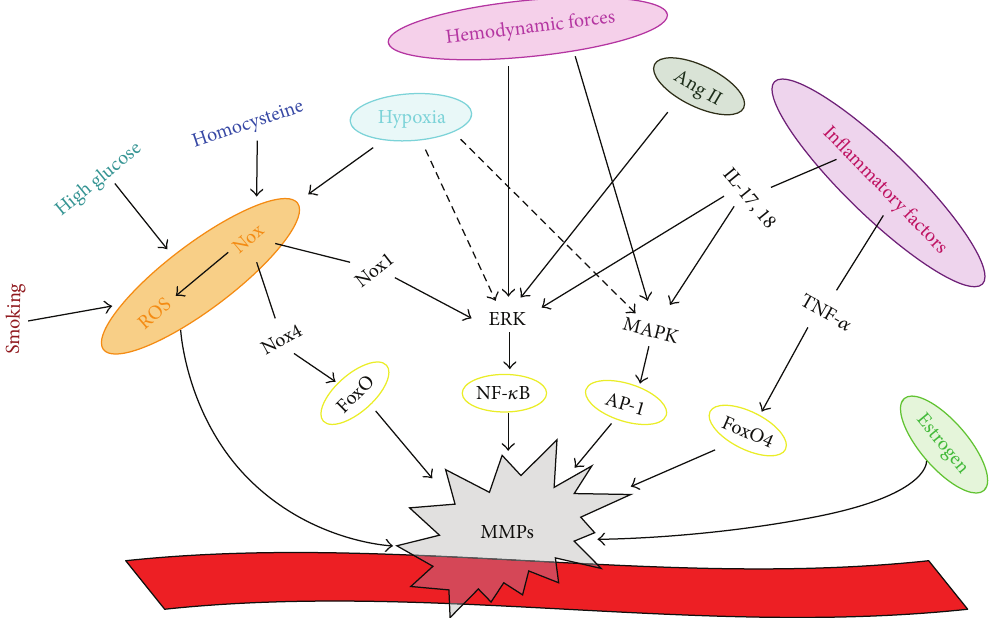
Figure 1: Major stimuli activating vascular